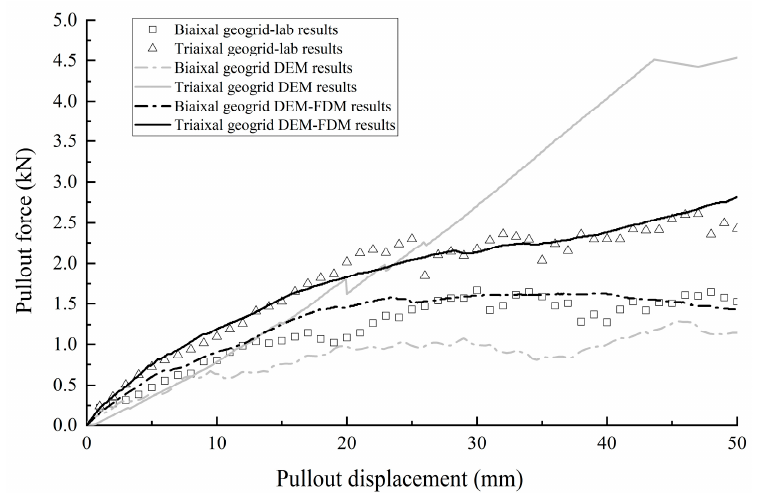
Figure 6. Comparison of geogrid pullout resistance between experimental and simulation results. The evolution of the contact forces between the particles and geogrid stress during pulling is shown in Figure 7. Each contact force between particles is represented at the contact point by a gray cylinder in the direction of the force, of which the diameter depends on the value of the force and of which the length is proportional to the distance between their centres. All graphs use the same scale factor. Figure 7 displays the strong contact forces in the vicinity of the biaxial geogrid area, which clearly shows the interlocking effect, which is consistent with previous DEM simulations [26]. It can also be seen that in the pullout process, a stress arch is gradually formed around the geogrid, indicating an interlocking effect between the geogrid and the ballast. Comparing the size and distribution of the force chain, it can be concluded that the force chain formed around the triaxial geogrid seems to be larger at the same pullout displacement, indicating that the triaxial geogrid has a better reinforcement effect than the biaxial geogrid. Arching around the geogrid at the front of the box is clearly observable in both models, indicating resistance to pulling. Therefore, the corresponding geogrid area suffered stronger stress, especially in the later stage during pullout. By contrast, at the same stage, the simulation with the triaxial geogrid (Figure 7b) shows larger stress than that with the biaxial geogrid (Figure 7a), which can be attributed to the triangular aperture facilitating stronger interlocking than the square aperture. In order to quantitatively analyse the contact force distribution between particles during pullout, the contact information for the geogrid-reinforced ballast was extracted and analysed, as shown in Figure 8. The sum of all contact forces in each direction interval was measured, and the number and the average value of all contacts were recorded. At the initial stage of the pullout, the contact force vector between ballasts was mainly observed in the vertical direction owing to the self-weight of the ballast and the vertical surcharge. With the progress of the pullout, the horizontal contact force gradually increased and gradually diffused from 0° to 45°. This indicates that the contact force between particles was gradually generated along, above and below the geogrid to produce the extra pullout resistance when the geogrid moved in the horizontal direction. The total contact numbers of these two kinds of geogrid-reinforced sample were similar. However, compared with the biaxial geogrid-reinforced ballast sample, the average contact force of the triaxial geogrid-reinforced sample was larger and more widely distributed at the same pullout displacement, which led to a better reinforcement effect.